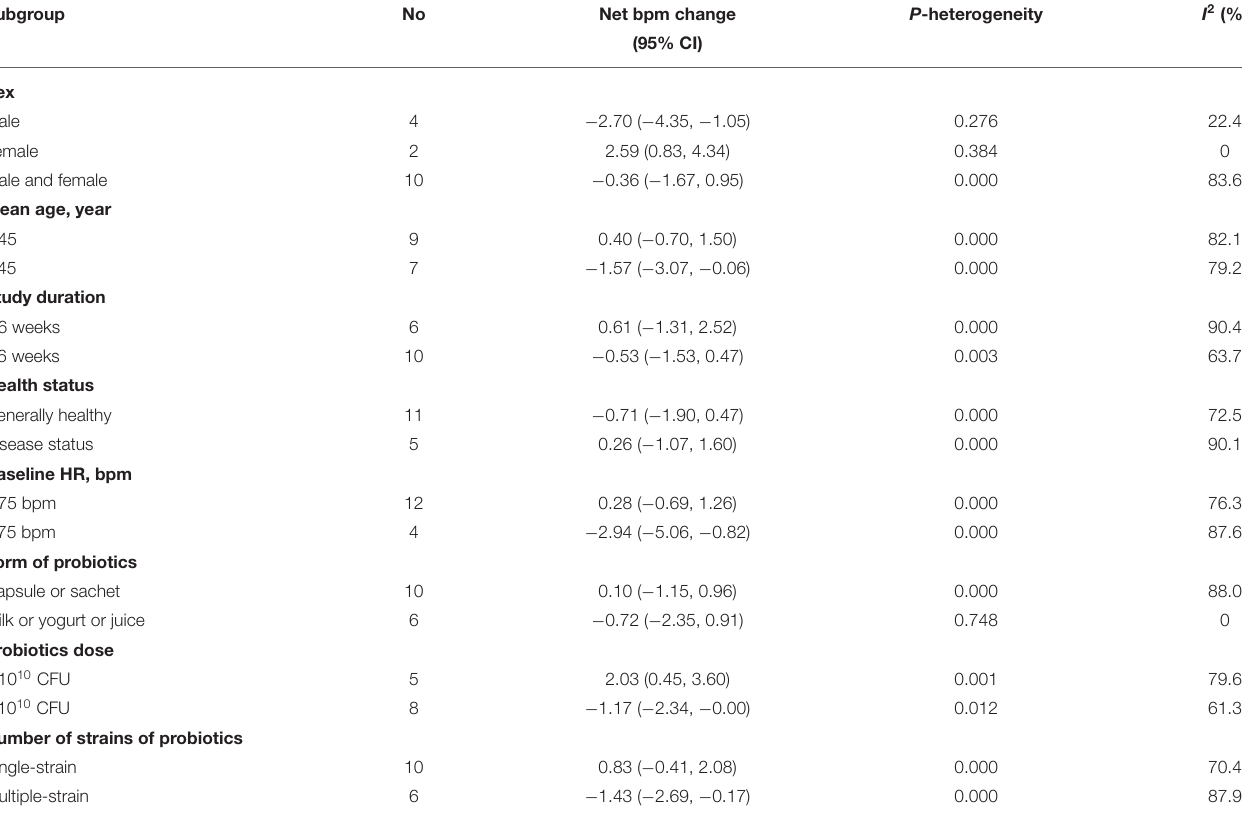
TABLE 2 | Subgroup analyses according to trial and participant